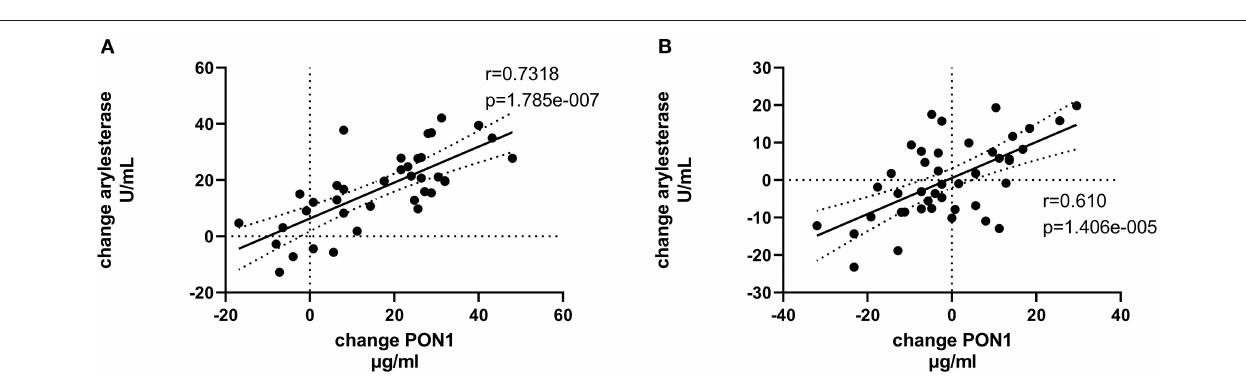
FIGURE 3 | Change in PON1 arylesterase activity vs. change in PON1 mass. (A) Transplant group. (B) Dialysis group.